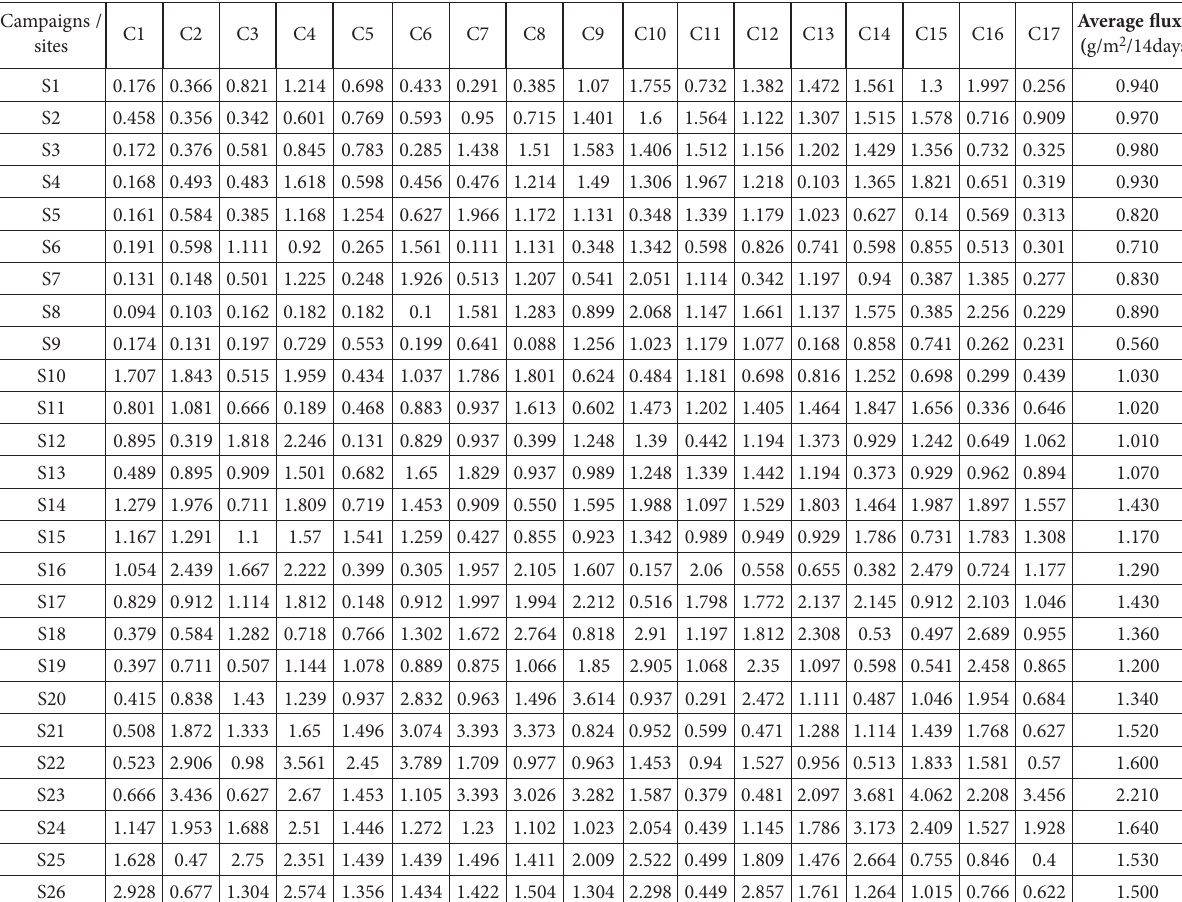
Table 1. Variation of the fluxes (g/m 2 /14days) of dry particulate deposits during the first period (from January to August, 2012) Campaigns /